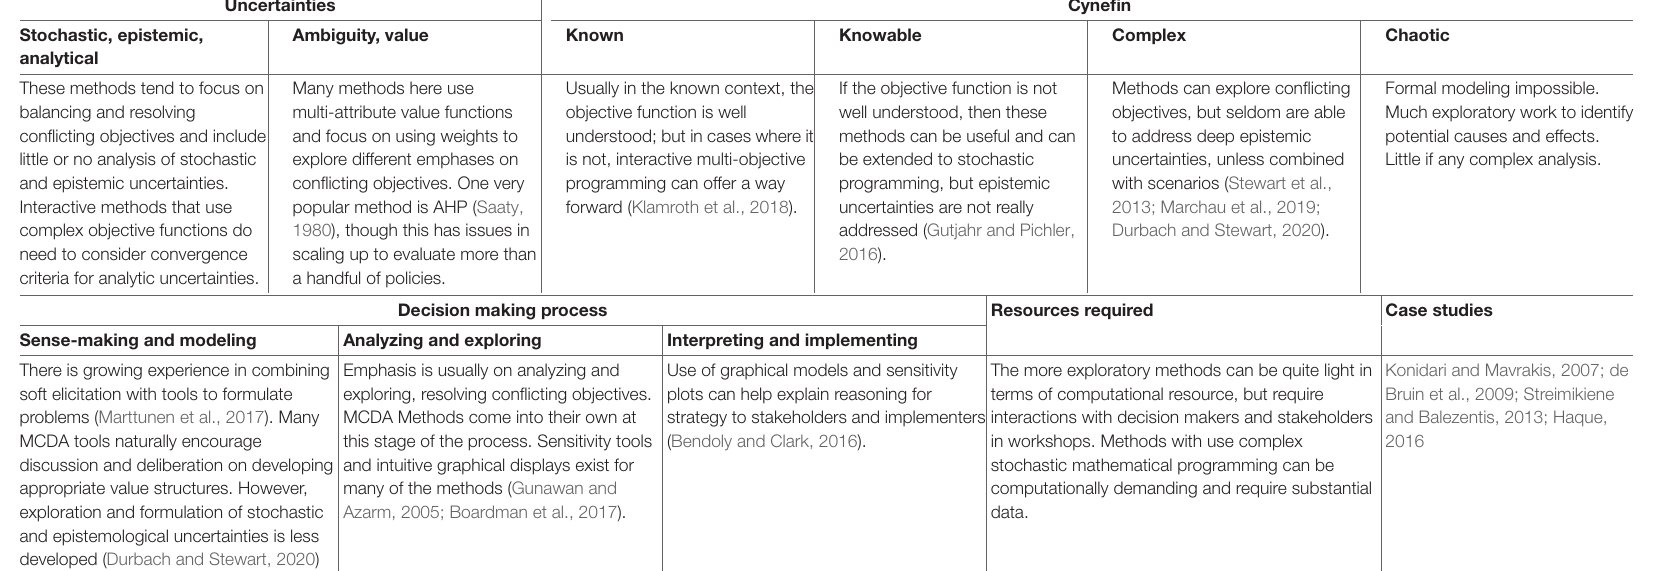
(f) Multi-criteria decision analysis (MCDA): full ranking and optimal seeking (Bell et al., 2001; Belton and Stewart, 2002; Bouyssou et al., 2006; Zopounidis and Pardalos, 2010; Tzeng and Huang, 2011; Velasquez and Hester, 2013; Kumar et al.,